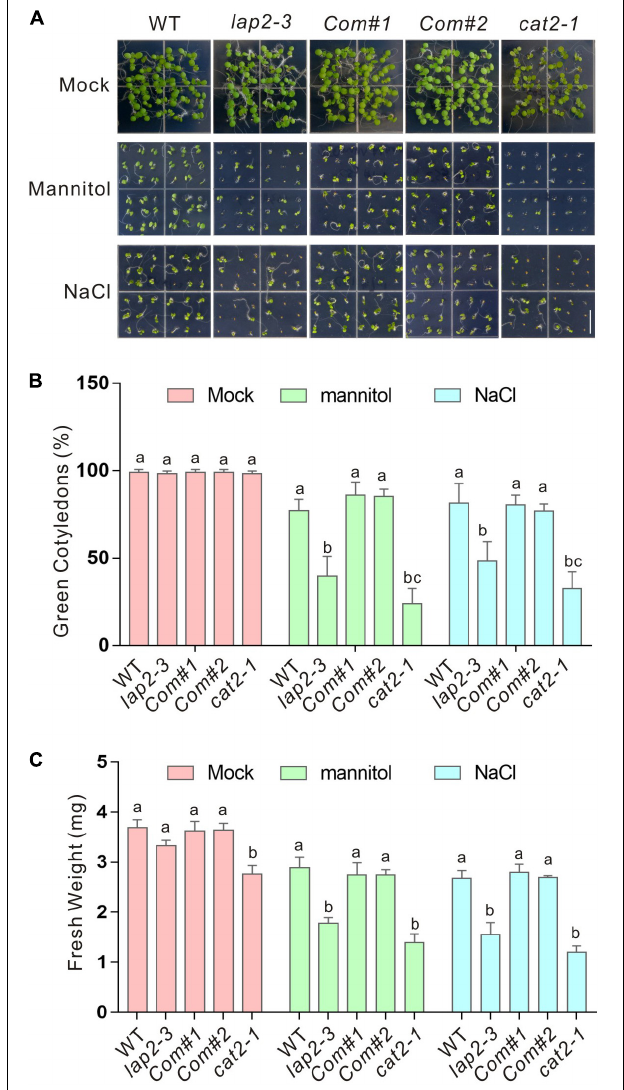
FIGURE 2 | The lap2-3 mutant is sensitive to salt or osmotic stress. (A) Images of 5-days-old wild-type, lap2-3 , LAP2 complementation lines and cat2-1 mutant seeds germinated on 1/2 MS medium without or with 250 mM mannitol or 125 mM NaCl. Bars = 0.5 cm. (B) Green cotyledon percentage of the wild-type, lap2-3 , LAP2 complementation lines and cat2-1 mutant in panel (A) . (C) Five-days-old wild-type, lap2-3 , LAP2 complementation lines and cat2-1 mutant seedlings grown on 1/2 MS medium were transferred to 1/2 MS medium without or with 250 mM mannitol or 125 mM NaCl for another 5 days, and the fresh weight was measured. Data are means ( ± SD) of three biological replicates. Bars with different letters in the same treatment indicate significant differences at p < 0.05, revealed using one-way ANOVA with Tukey’s multiple comparison test.